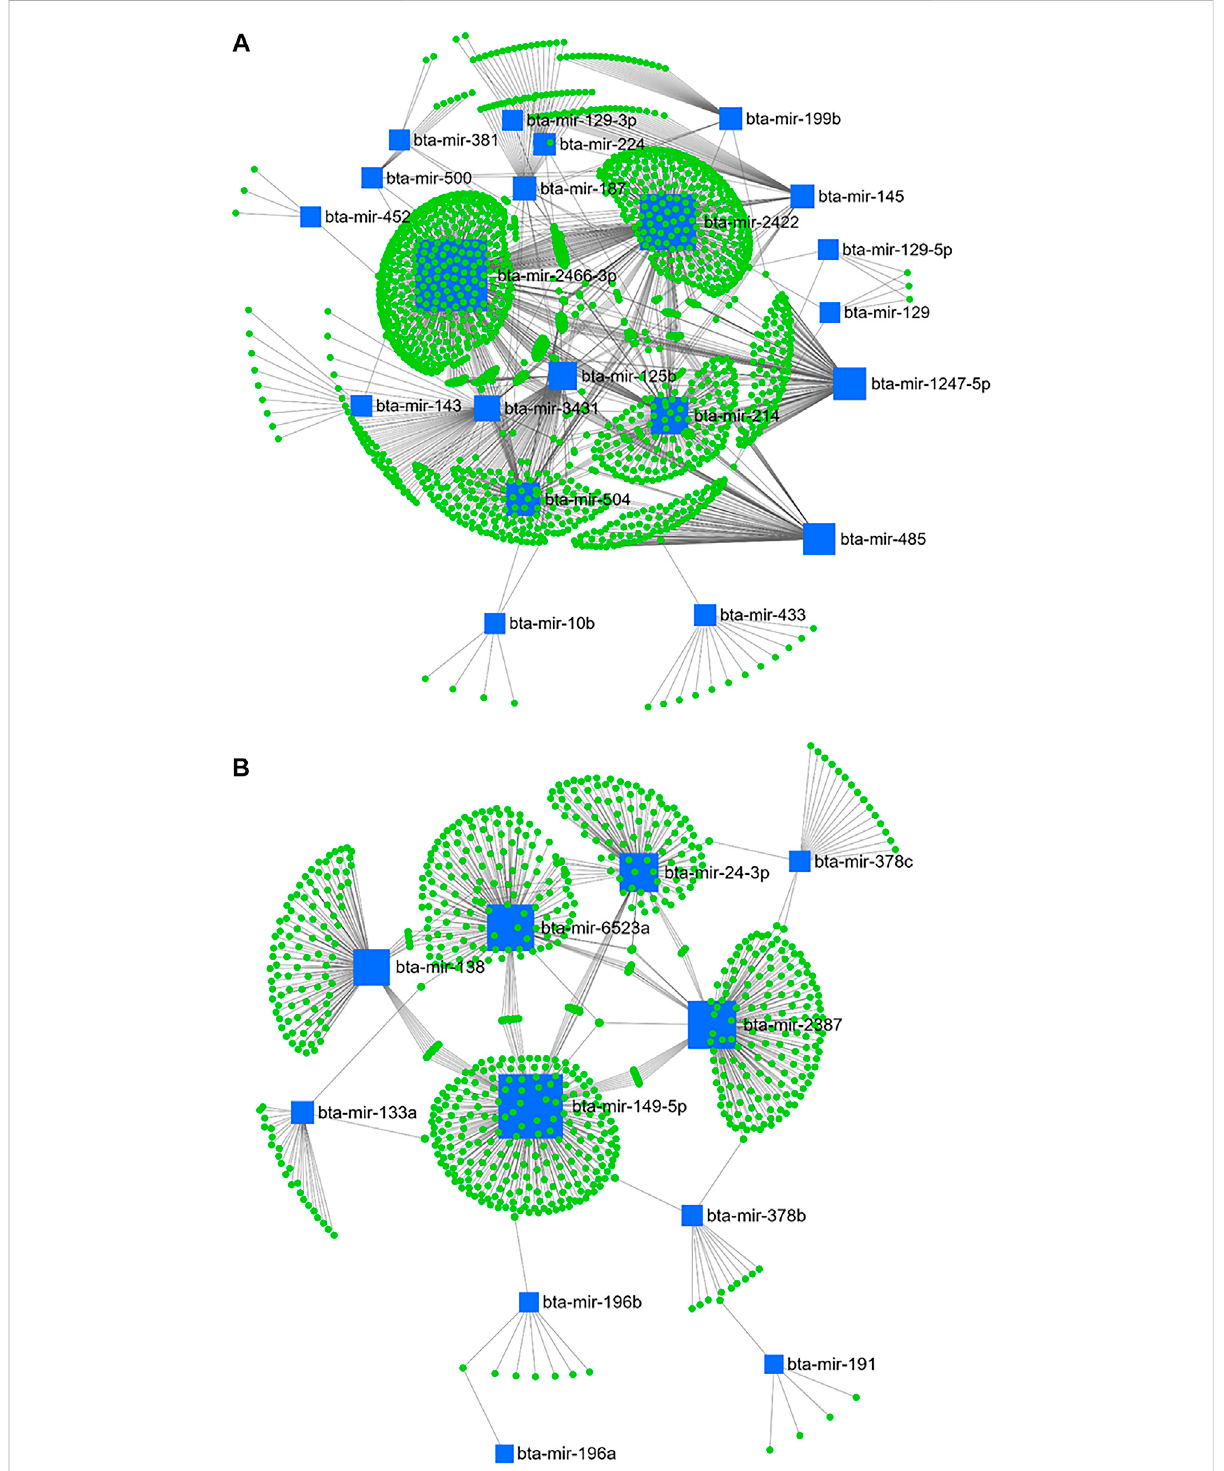
FIGURE 10 miRNA/mRNA network analysis. The regulation network of downregulated (A) and upregulated (B) miRNAs and predicted target mRNAs in d+28/+1 is illustrated by Cytoscape software. The nodes represent the mRNA (green), and the boxes represent the miRNA (blue). The box size corresponds to the centrality and betweenness of miRNA in constructing the